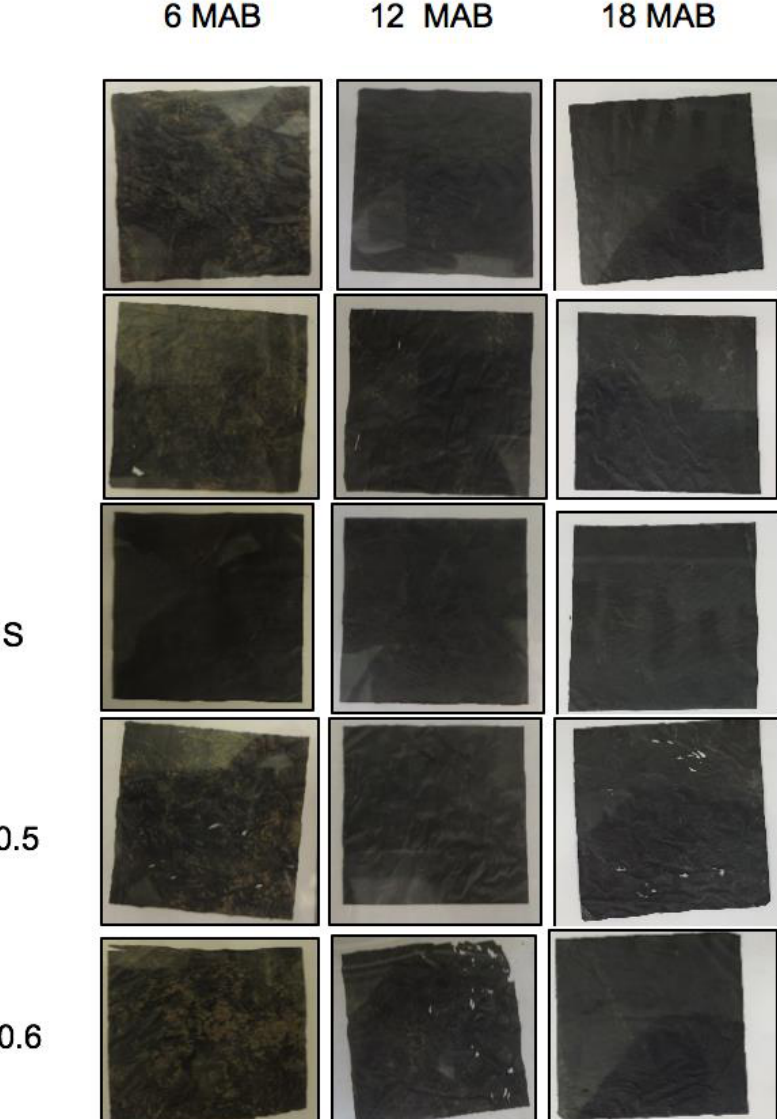
Figure 4. Biodegradable plastic mulch (BASF and Novamont, where 0.5 and 0.6 indicate the film thicknesses: 0.5 mil = 12.7 µ m and 0.6 mil = 15.2 µ m) treatments removed from mesh bags 6 months after burial (MAB) (October 2018), 12 MAB (April 2019), and 18 MAB (October 2019). Prior to burial, mulches were weathered on top of a raised bed in a raspberry field for 11 months, then cut into squares measuring 25 cm 2 and buried in April 2018 in their respective plots at a depth of 10 cm. All treatments were buried with 100g of soil in the mesh bags, except BASF 0.6NS, which was buried without soil in the mesh bags.